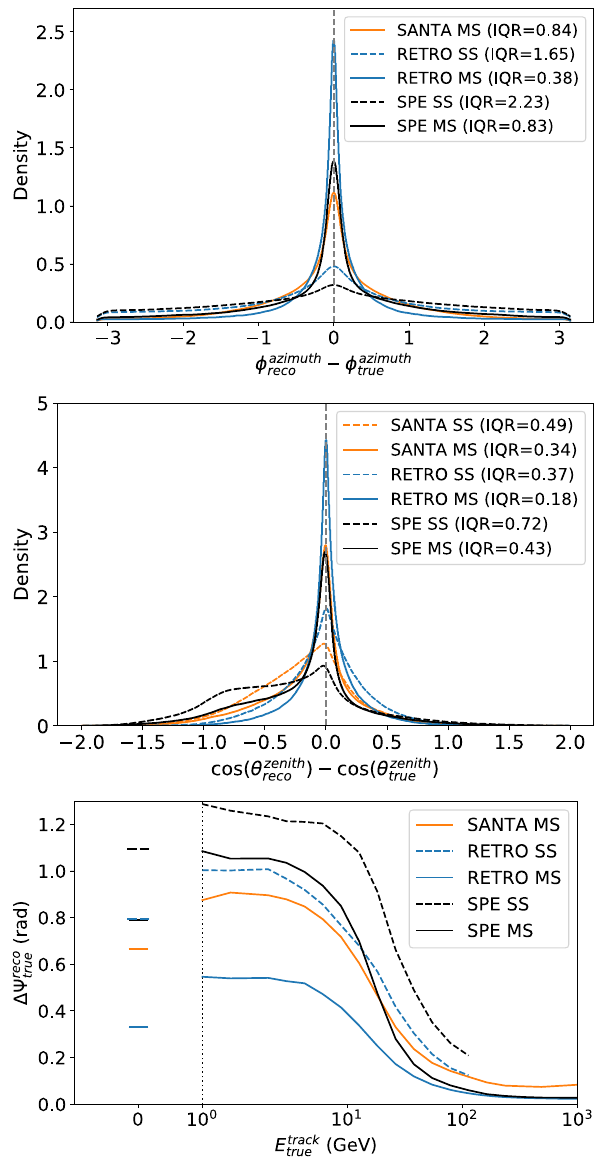
Fig. 16 Angular resolutions for single-string (SS) and multi-string (MS)events.Theresultsof retro (blue)and santa (orange)areshown together with the spefit (black) reconstruction. Since santa has no sensitivity to azimuth for single string events the respective line is not shown. The lines in the first two plots of this figure are the result of a kernel density estimation (KDE) to the actual distributions. IQR is the 50% interquantile range, i.e. the difference between the 0.25 and the 0.75 quantile. The last plot shows the median angle between true and reconstructed direction ( (cid:5)(cid:15) reco true ) vs. the true track energy. Single string lines are just shown up to 100GeV, because there are very few single string events above these